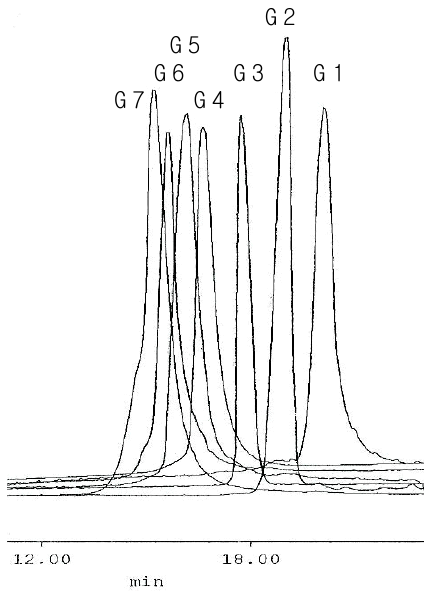
Figure 1. GPC chromatogram of 1 st to 7 th generation carbosilane